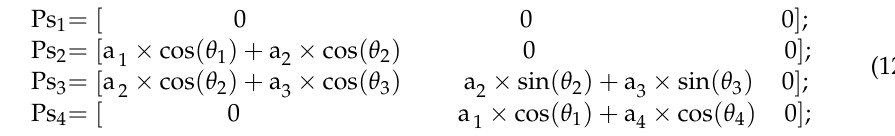
Figure 8. Touch points of the range sensor (blue), AprilTag center (cyan), AprilTag corners (cyan), and of the sensor unit principle point (yellow). Figure 9. Transformation from world-corresponding points to sensor touch points in the image plane. Figure 10 demonstrates the relationship of a 2D image plane, presented in red and in left, and its projected 2D world plane, depicted in light green and in right. Figure 10. Image plane, red plane, and world plane, in light green, relations by homography.